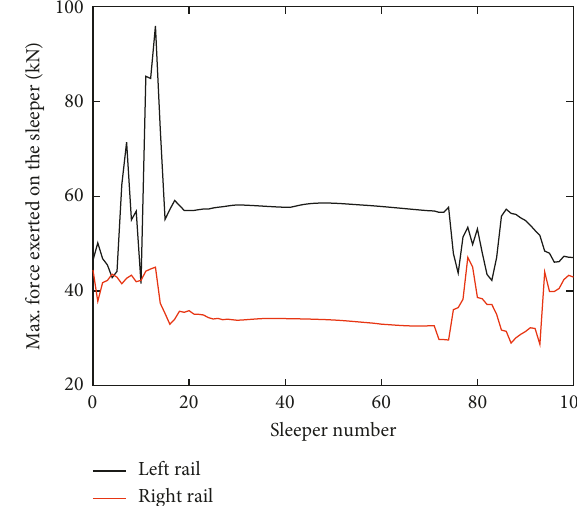
Figure 10: Maximum force exerted on the sleeper.